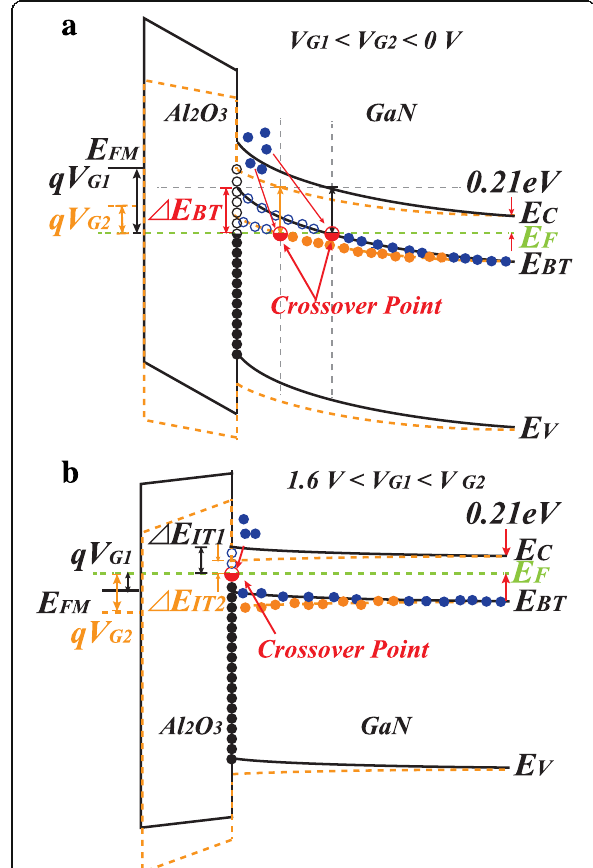
Fig. 4 a The energy band diagram in depletion region to illustrate the conductance maximum loss induced by buffer traps irrelevant with V G . b Energy band bending in the subthreshold region to illustrate the conductance maximum loss induced by interface traps correlated with V G